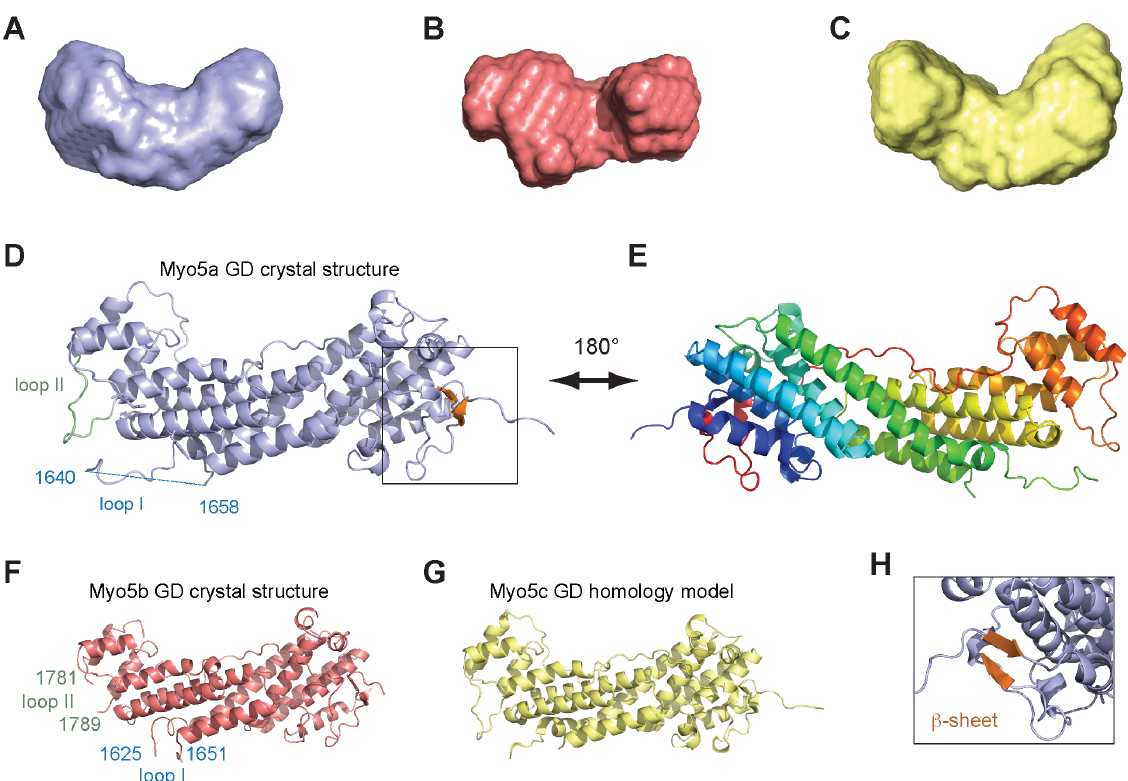
Figure 1. X-ray structures and Small-Angle X-ray Scattering (SAXS) models of globular domains from human type V myosins. ( A–C ) Surface envelopes calculated from SAXS data revealed that Myo5a GD (A), Myo5b GD (B), and Myo5c GD (C) have very similar shapes in solution. See Figure S1 in File S1 for details of SAXS measurements. ( D ) Ribbon representation of the Myo5a GD crystal structure at 2.2 A˚, with the small C-terminal beta-sheet shown in orange. The missing loop I (1640 to 1658) is depicted as a blue dashed line, loop II is highlighted in green. ( E ) Same structure as in (D), but rotated 180 u around the vertical axis. Rainbow color-coding follows the peptide chain from its N-terminus in blue to its C-terminus in red. ( F ) Ribbon representation of the Myo5b GD crystal structure at 3.1 A˚ resolution. First and last residue of the missing loops I and II are depicted in blue or green, respectively. ( G ) Ribbon representation of the modeled structure of the GD from Myo5c, calculated with the program Modeller and the structures of Myo5a (D–E) and Myo5b (F) as templates. For a Ramachandran plot of the computed model, see Figure S4 in File S1. ( H ) Close-up of (D), slightly rotated to better show the position of the small beta-sheet (orange) that connects the very N-terminus with the C-terminus. Figures were generated with the program Pymol.